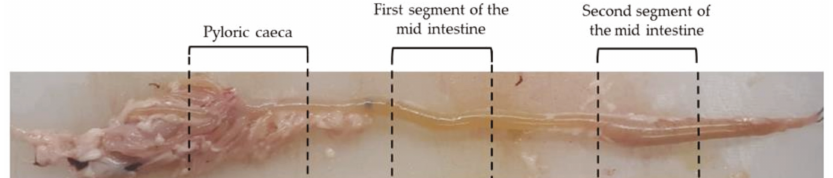
Figure 20. Regions of the rainbow trout mid-intestine where samples were collected: pyloric caeca, first segment of the mid-intestine, and second segment of the mid-intestine.